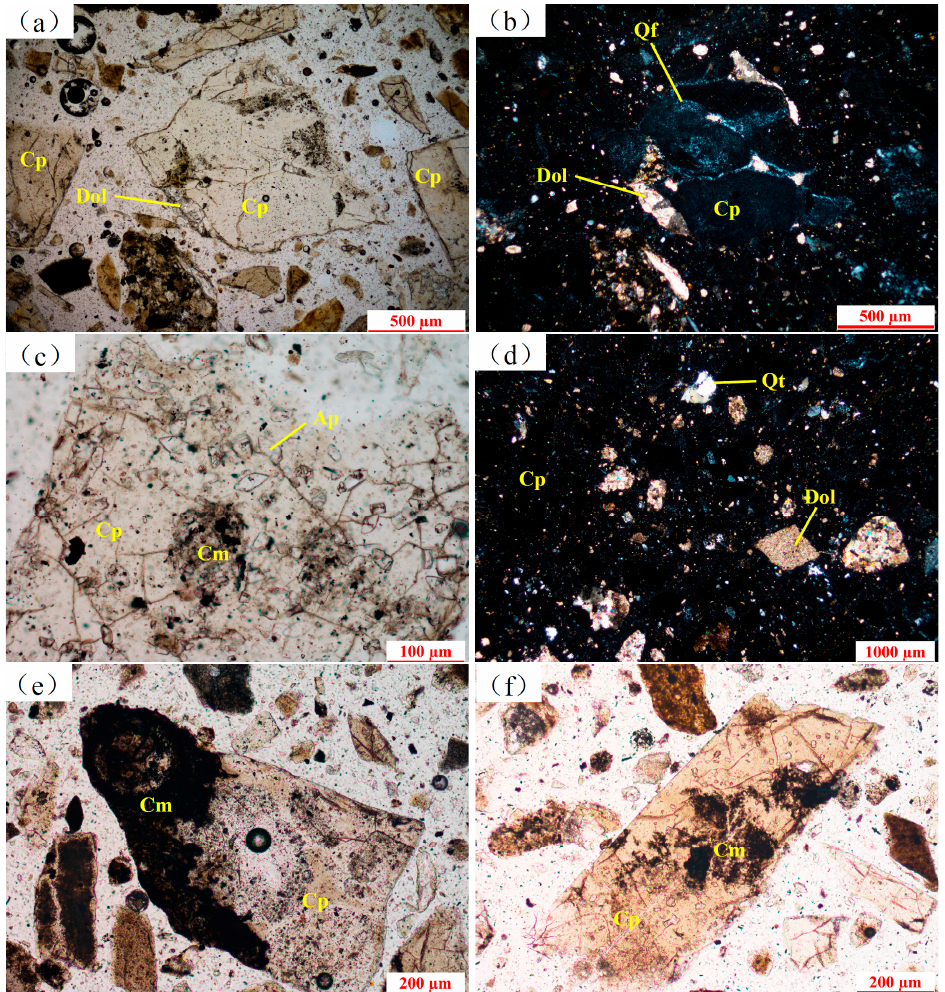
Figure 2. Optical microscopy images of raw ore observed with: ( a , c , e , f ) plane-polarized light; ( b , d ) cross-polarized light (Cp: collophane; Ap: apatite; Qf: Quartz and feldspar minerals aggregate Qt: quartz; Cm: clay minerals; Dol: dolomite).